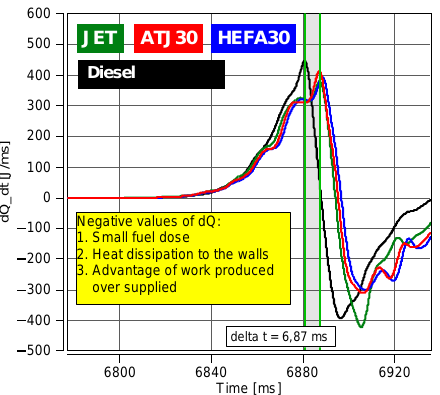
Figure 13. Software for the image analysis. The sequence of the autoignition spots pertains to the images with the dwell time of dt = 2.5 ms (every 10th image). The analysis was initiated from the 65th image (the first autoignition spot appeared there). This denotes the time of 65 × 0.2 ms = 13 ms from the start of the falling curve of the camera-controlling signal. The point in time, from which